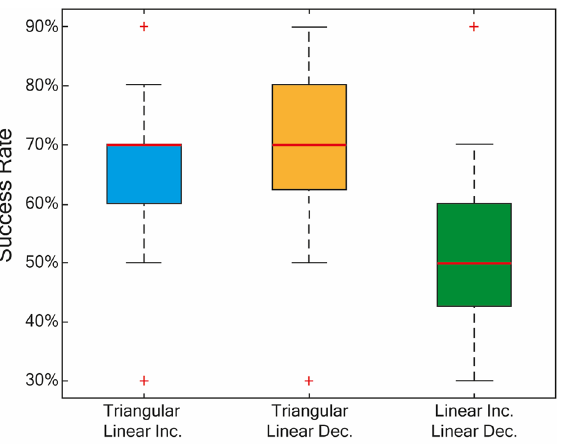
Figure 5. The data obtained by the 2AFC match-to-sample task were collected and analyzed. The results indicate that in about 70% of cases, volunteers were able to correctly distinguish the stimulation carried out with a linear or triangular ramp, indicating that the dynamics of the waveform can influence the induced sensation. On the other hand, it was more difficult for volunteers to distinguish between waveforms with similar dynamics as in the case of the comparison between linear ramps, in which the success rate was only